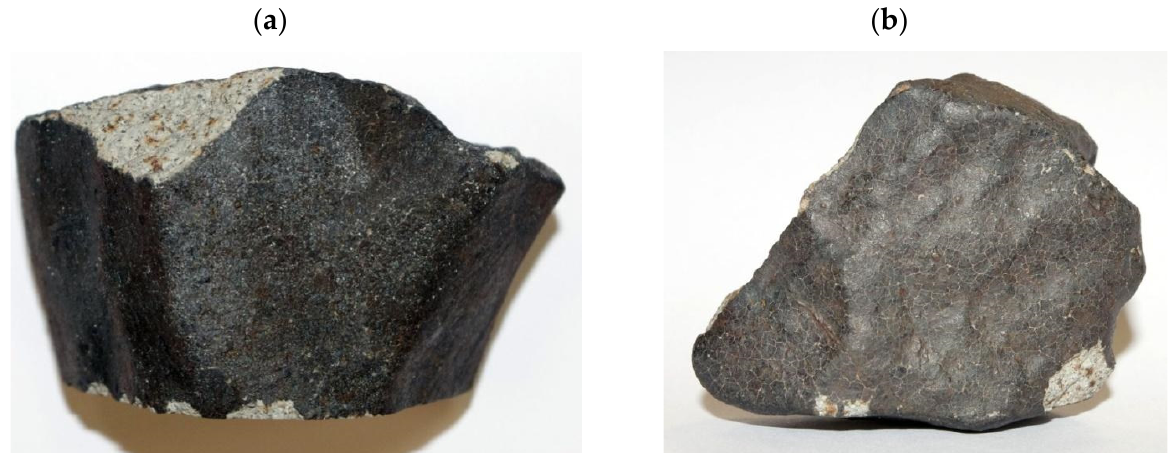
Figure 2. Photo of two HaH 346 specimens from two different expeditions ( a ) Close to Ashuwairif town (HaH 346-201), ( b ) Close to Gheriat town (HaH 346-3).